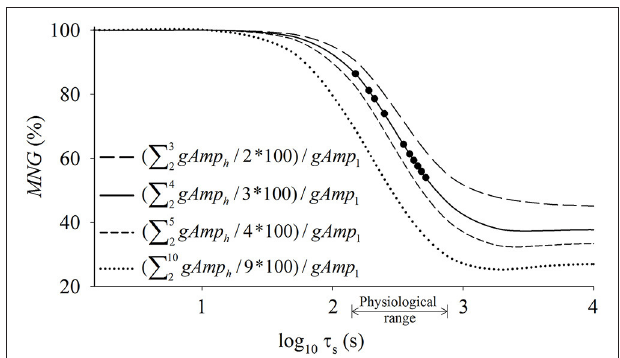
FIGURE 3 | Computer simulations were performed to generate different oxygen uptake ( ˙ VO 2 ) responses considering different values of time constant ( τ s ) that defines the speed of the ˙ VO 2 adjustment to random exercise. The ˙ VO 2 data were transformed to frequency domain and the mean normalized gain amplitude ( MNG ) was obtained considering the normalized system gain obtained from different frequency ranges. The equations describe how the MNG was obtained from the ˙ VO 2 data. The x-axis scale was converted to log 10 for a better visualization of the sigmoidal characteristics of the relationship between MNG and τ s . The symbols “ • ” represent the simulated data from Figure 2D . Please see Equation (4) and text for further details regarding the equation parameters and procedures. Notice that the linear portion of the sigmoid function is always located at the physiological portion of tau values (i.e., from 10 to 100